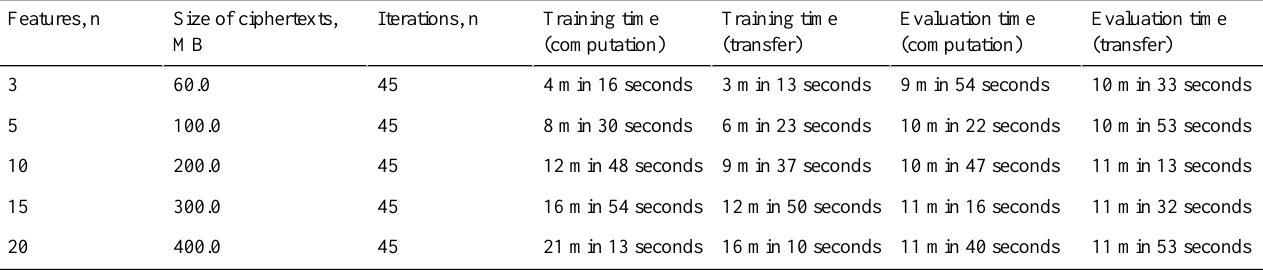
Table 7. Scalability of the proposed protocol for different numbers of features (3 data